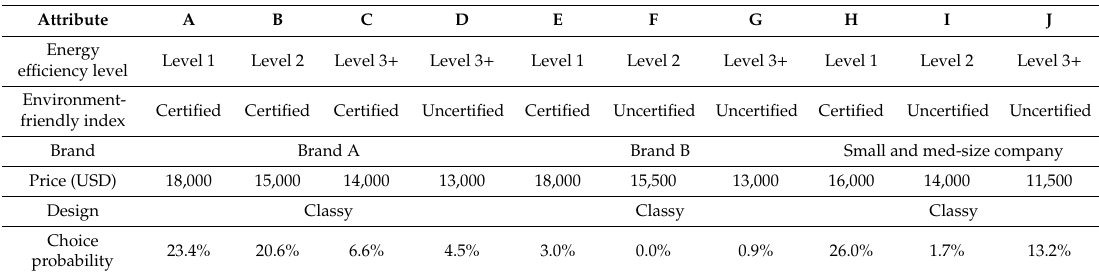
Table 6. The base scenario of the window market.